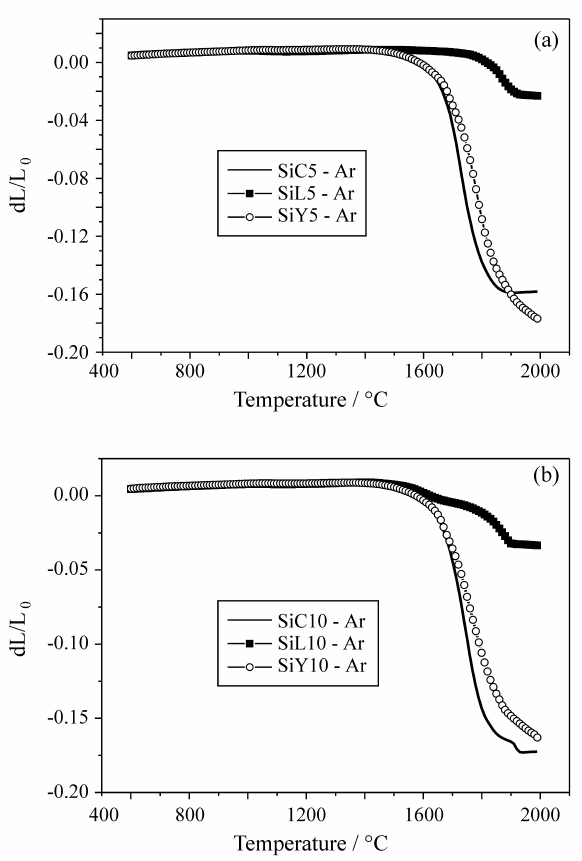
Figure 5. The results of dilatometric experiments: linear shrinkage vs. temperature while sintered in argon: a) 5wt% α -SiC; b) 10wt% α -SiC.